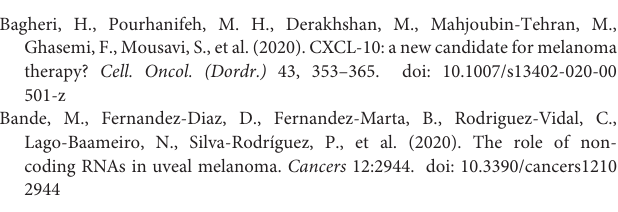
Supplementary Table 2 | The correlation between the ICI scores and